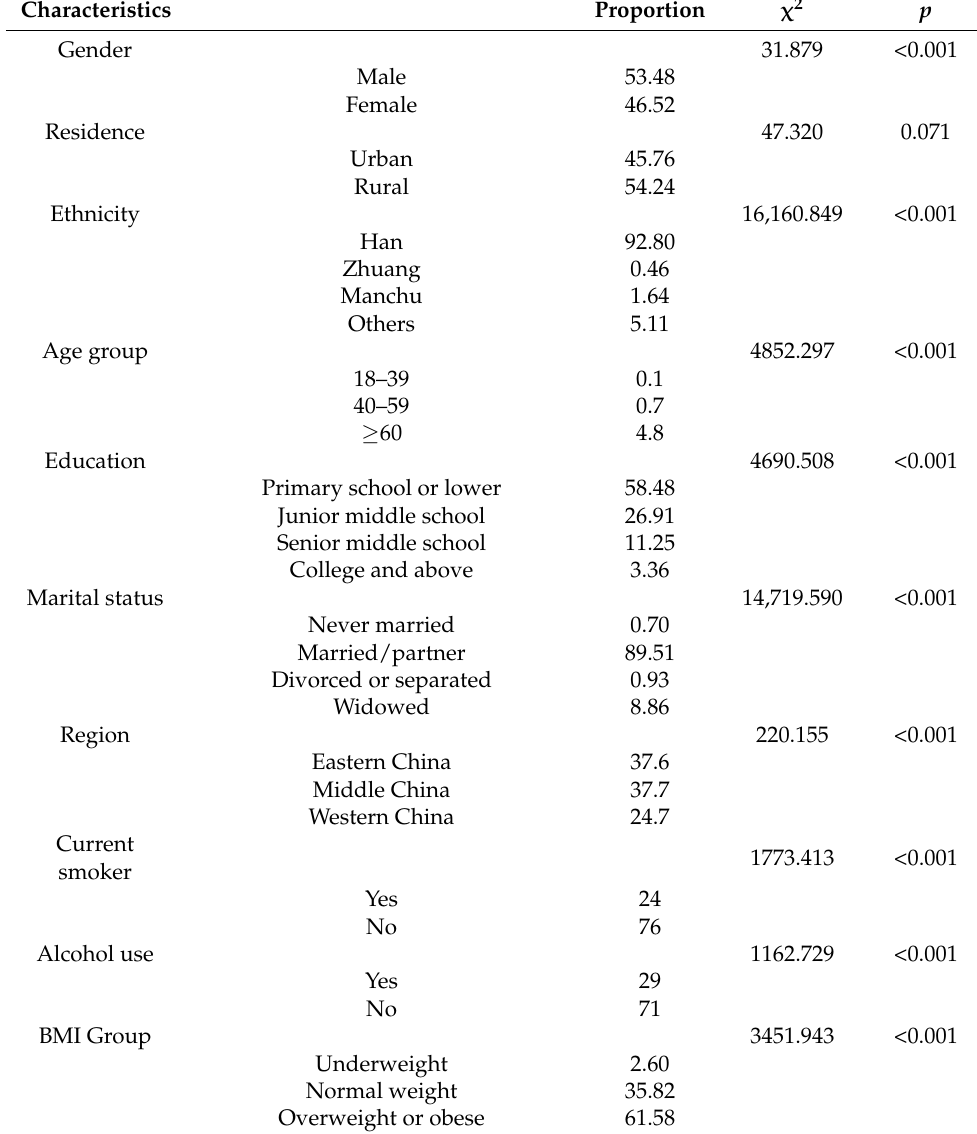
Table 1. Characteristics of stroke patients ( n = 6580) of the China National Chronic Disease and Nutrition Survey (2015) in China